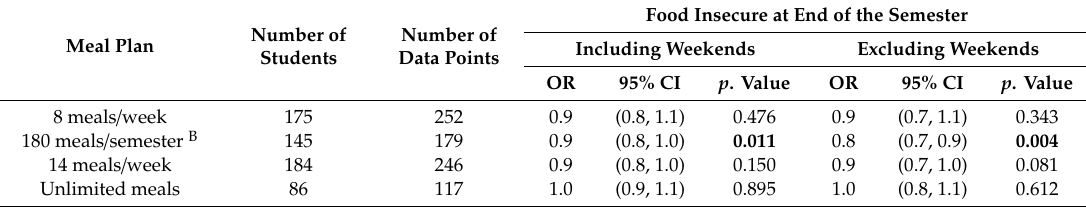
Table 4. Results of the logistic generalized estimating equation (GEE) determining if food insecurity at the end of the semester is associated with number of meals used A